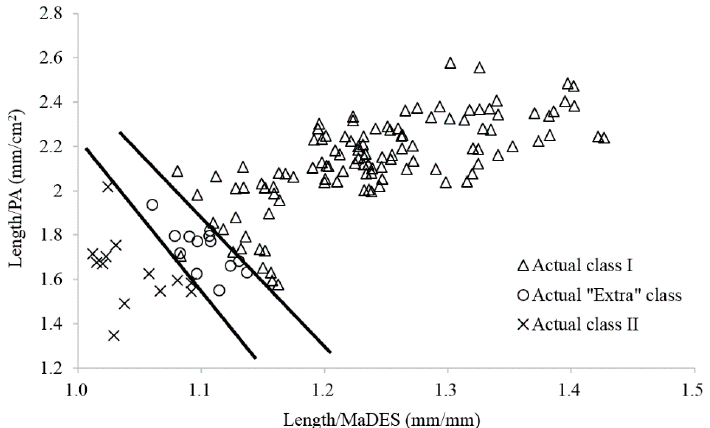
Figure 6. Improved classifications of samples in the estimated class I based on two linear combinations of length/MaDES and length/PA values.